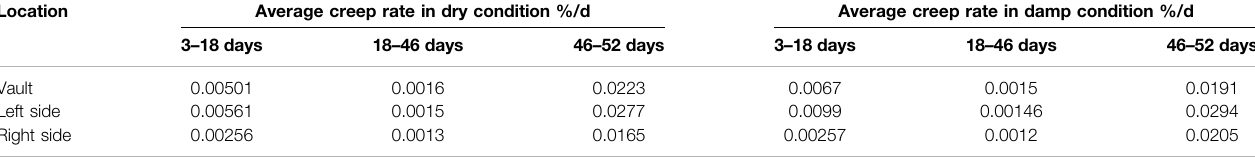
TABLE 6 | Creep rates of surrounding rocks in different stages under dry and damp states. Location